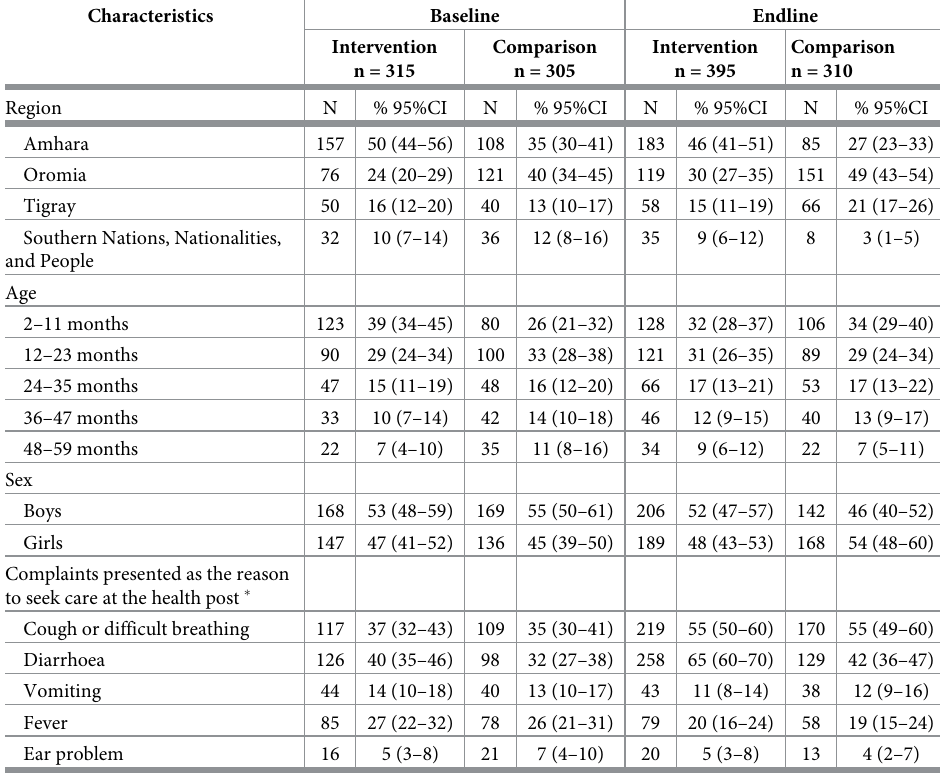
Table 1. Characteristics of sick 2–59 months old children at health posts who were offered integrated community case management services at baseline (December 2016- February 2017) and endline surveys (December 2018-Feb- ruary 2019) in intervention and comparison